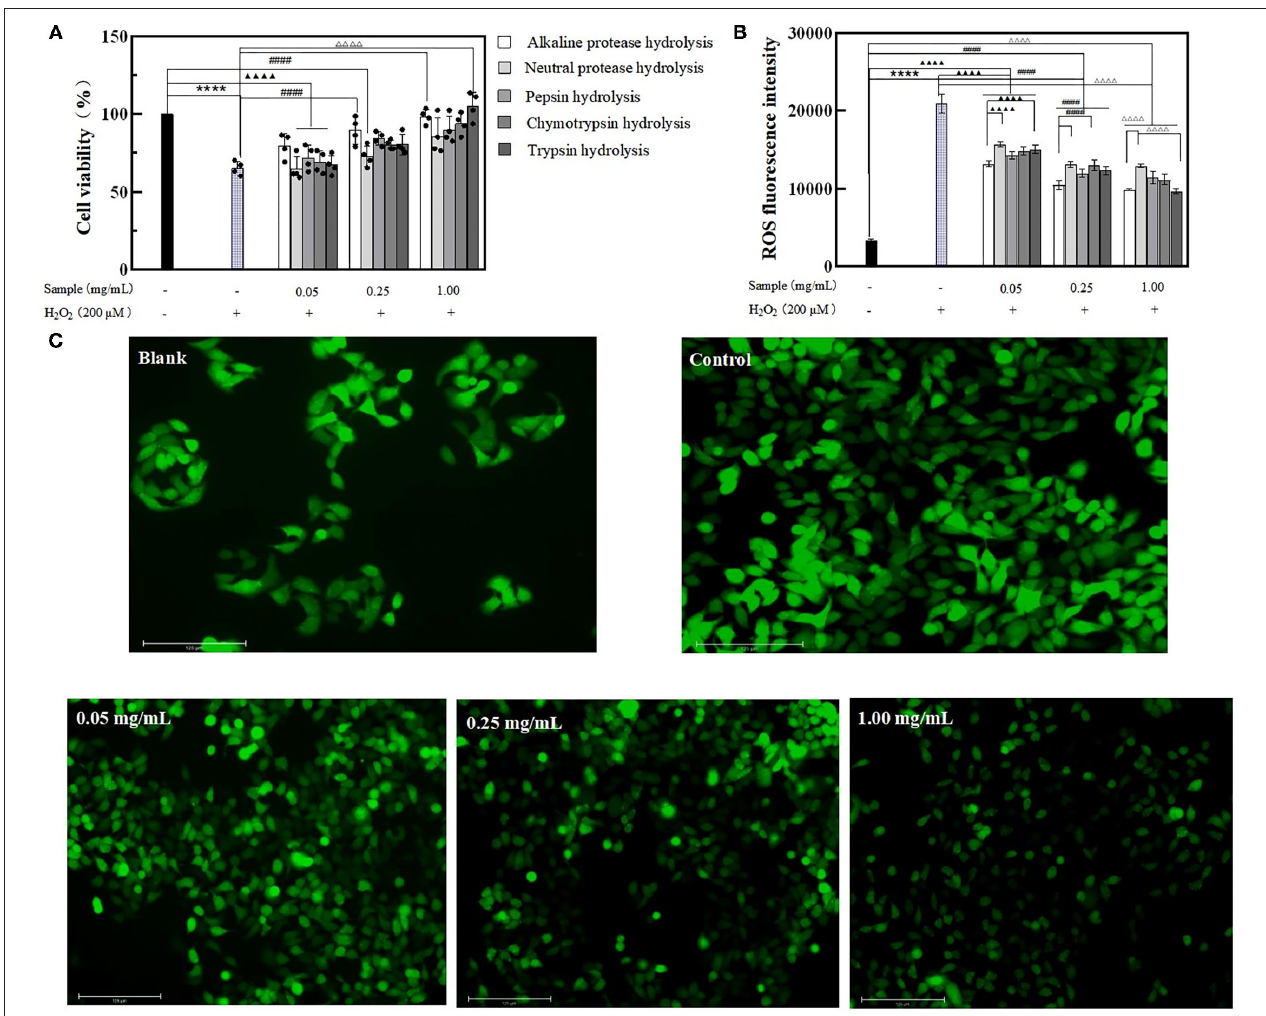
FIGURE 4 | The effect of BRPHs on alleviating cell aging. (A) cell viability; (B) ROS fluorescence intensity; (C) ROS fluorescence image of Caco-2 cells treated with 0.05, 0.25, and 1.00 mg/ml of A-BRPH. Cells were pretreated with the sample at 0.05, 0.25, 1.00 mg/ml for 24h before exposure to 200 µ m H 2 O 2 for 1h. Data were shown as mean ± SEM, n = 4. ANOVA: ****, p < 0.0001 compared with control; NNNN , p < 0.0001 compared with Caco-2 cells treated with 0.05 mg/ml sample for 24h; ####, p < 0.0001 compared with Caco-2 cells treated with 0.25 mg/ml sample for 24h; 1111 , p < 0.0001 compared with Caco-2 cells treated with 0.25 mg/ml; sample for 24h. BRPH, broken rice protein